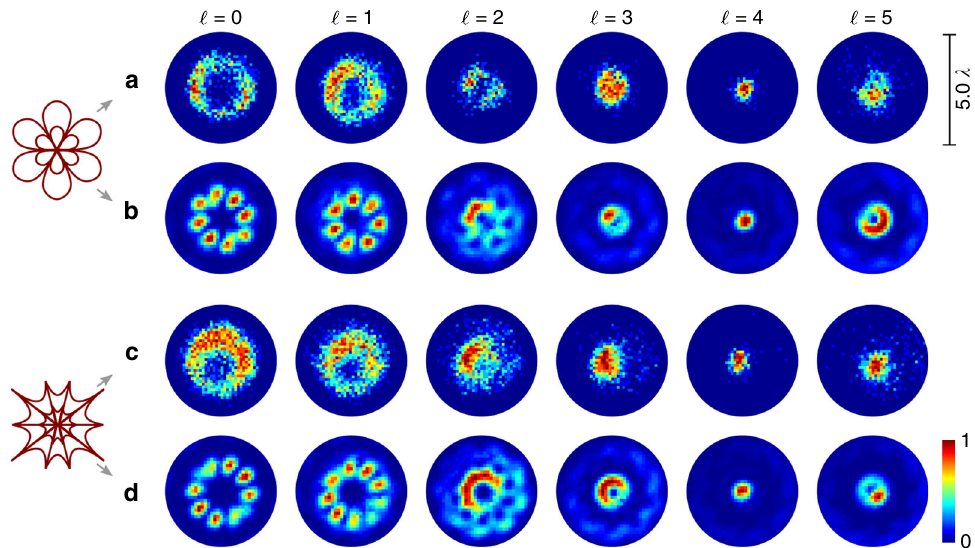
Fig. 5 Detecting non-paraxial fi elds by fl uorescent SAM. The normalized fl uorescence intensity of tightly focused vectorial fl ower or web ( σ 12 = ±8) with additional phase vortices of charge ‘ is analyzed experimentally ( a and c , respectively) as well as numerically ( b and d , respectively), proving the detection of non-paraxial properties. Shown scale corresponds to focal size